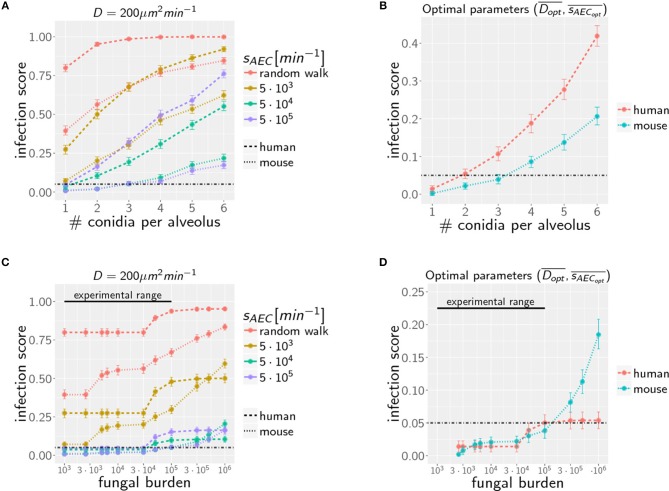
Infection scores IS as a function of the AON (A,B) and the fungal burden (C,D) for selected secretion parameters with diffusion coefficient D=200 μm2min-1
(A,C) and for optimal chemokine parameters Dopt¯ and sAECopt¯
(B,D) in mice and men. Dashed-dotted black line indicates the threshold infection score at ISt = 5%. Error bars represent 95% confidence intervals. Black line represents the experimental range of fungal burden, which is reached in typical mice model experiment.